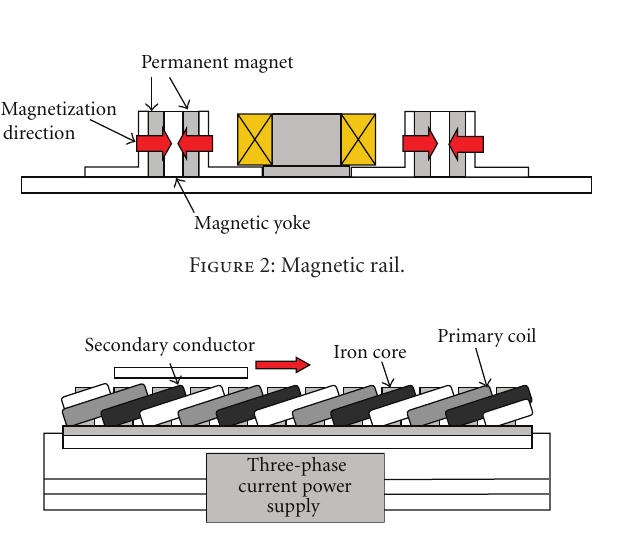
Figure 3: Linear induction motor. Table 1: Specifications of the permanent magnet.